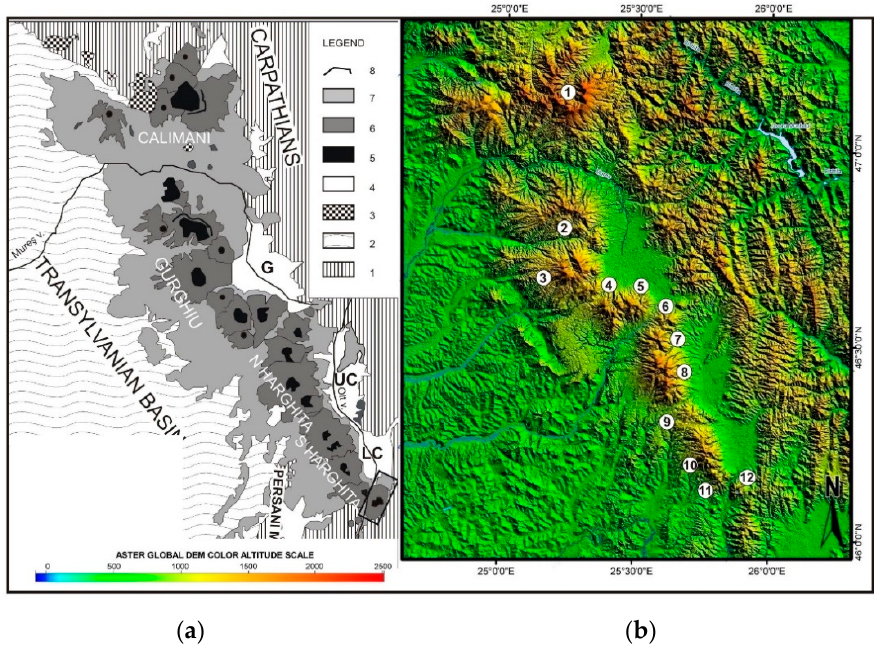
Figure 6. Volcanic facies sketch map ( a ) and ASTER false-color topography ( b ) of the C ă limani– Gurghiu–Harghita volcanic range. Legend of the facies sketch map: 1. East Carpathians fold-and- thrust-belt; 2. Transylvanian Basin; 3. “Subvolcanic zone” intrusions; 4. Quaternary intra-mountain basins (G—Gheorgheni basin; UC—Upper Ciuc basin; LC—Lower Ciuc basin); 5. Central volcanic facies; 6. Cone (proximal) volcanic facies; 7. Ring-plain (medial) volcanic facies; 8. Topographic caldera rim. Volcanic edifices on the ASTER image ( b ): 1. C ă limani caldera; 2. Fâncel-L ă pu ș na; 3. Seaca-T ă tarca; 4. S umuleu; 5. Ciumani-Fier ă straie; 6. Ostoros ; 7. Ivo-Cocoizas ; 8. V â rghis ; , , , , 9. Luci-Lazu; 10. Cucu; 11. Pilis ca; 12. ,